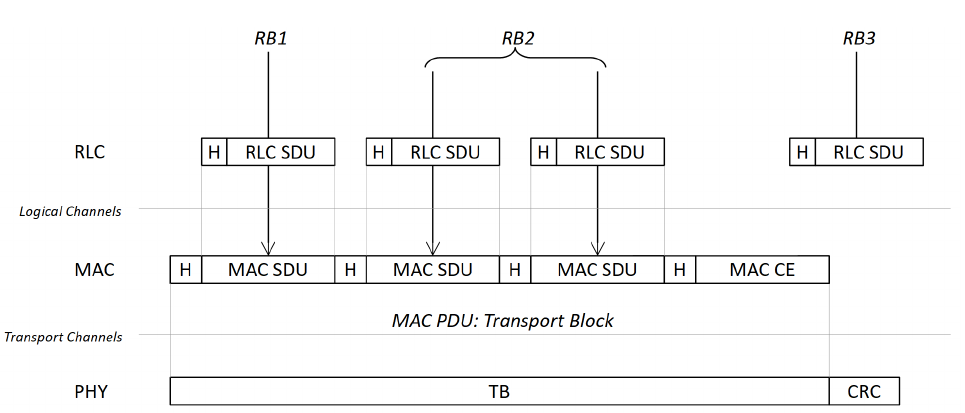
Figure 1. Example of the filling out of a Transport Block for a